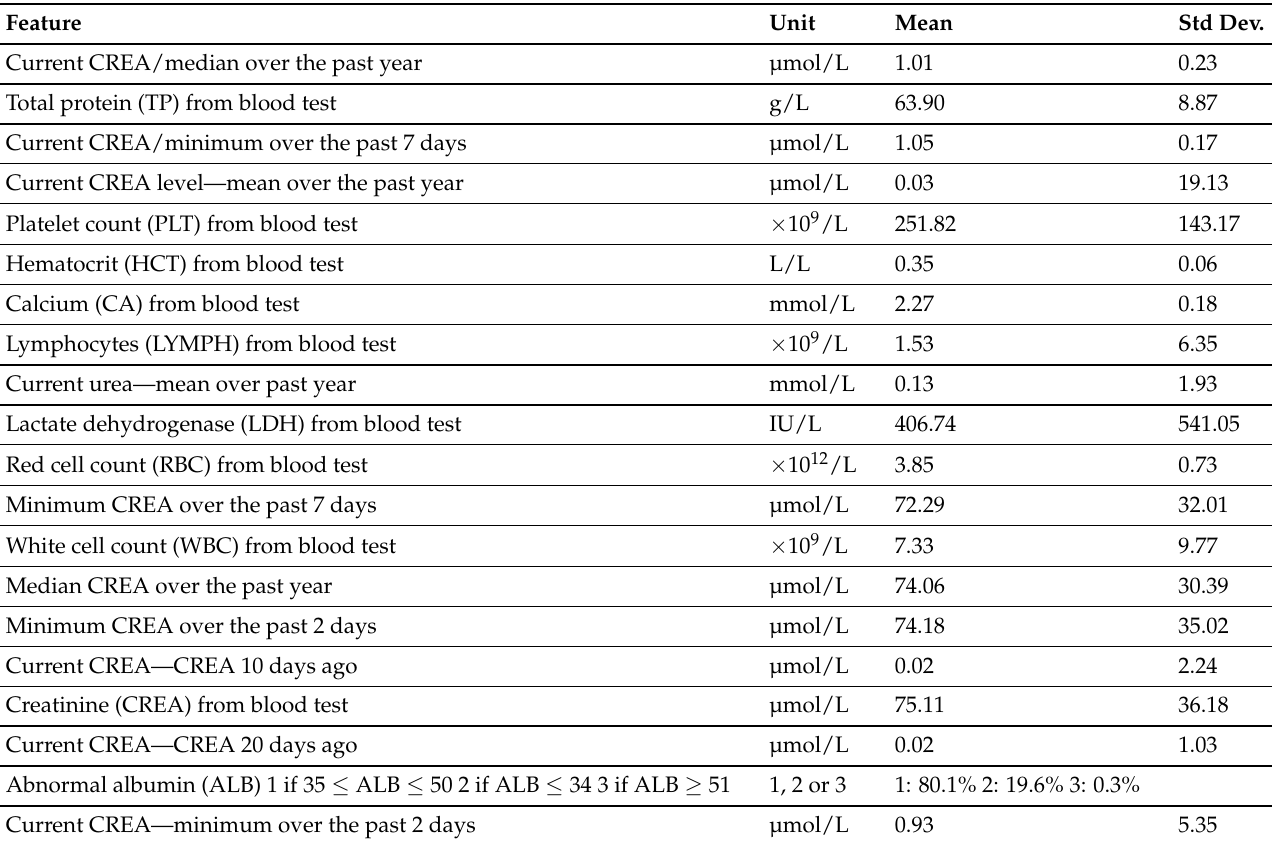
Table 1. Flow diagram of the data process. The process the data went through from creation to the output model including training/test split and removed data. Feature selection was an iterative process using recursive feature elimination as shown in the flow